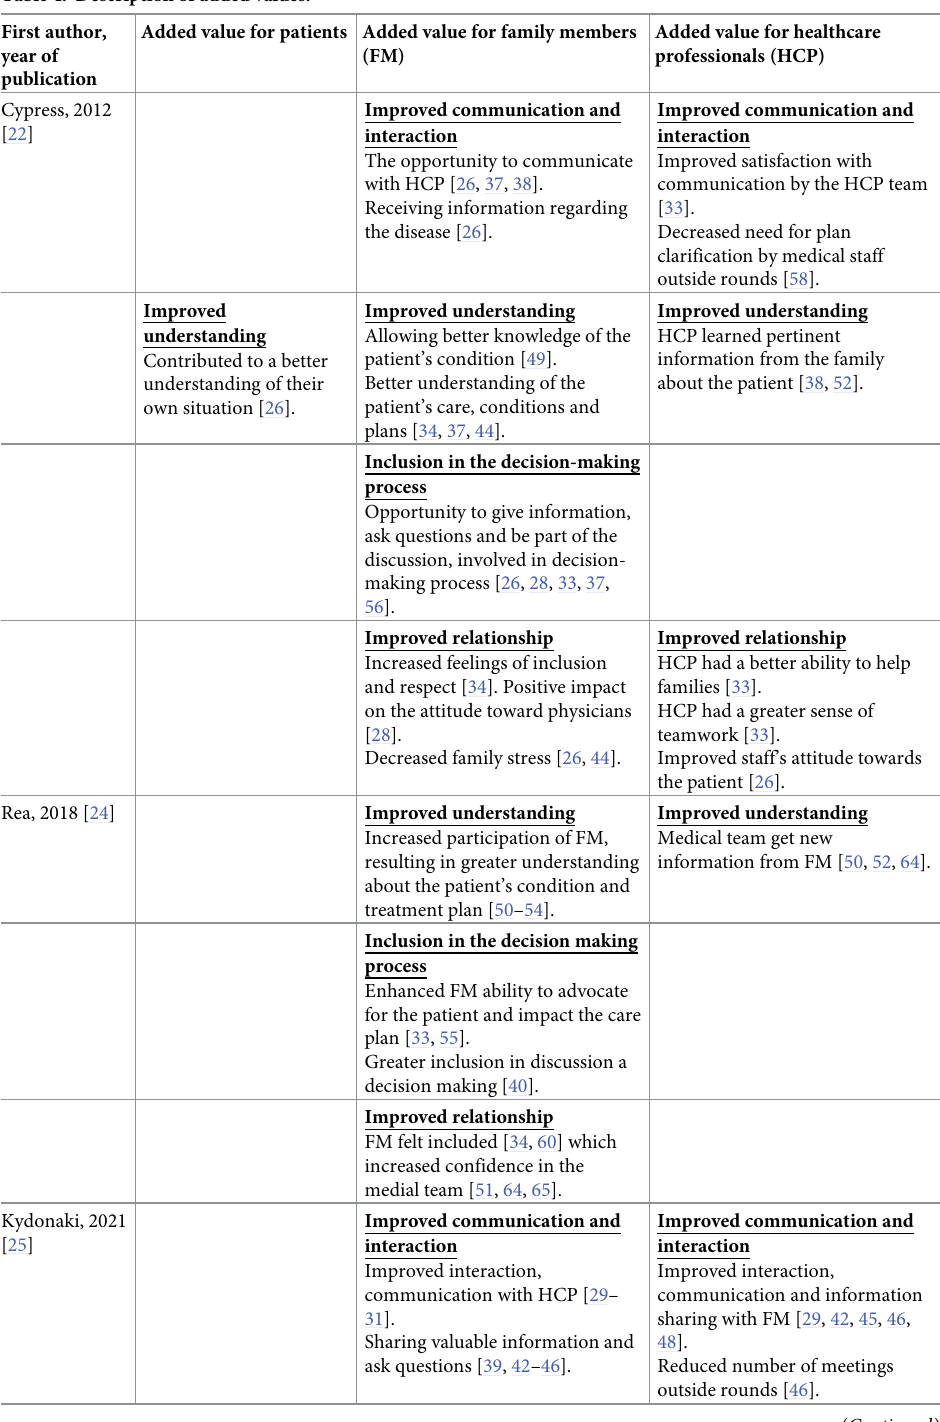
Table 4. Description of added